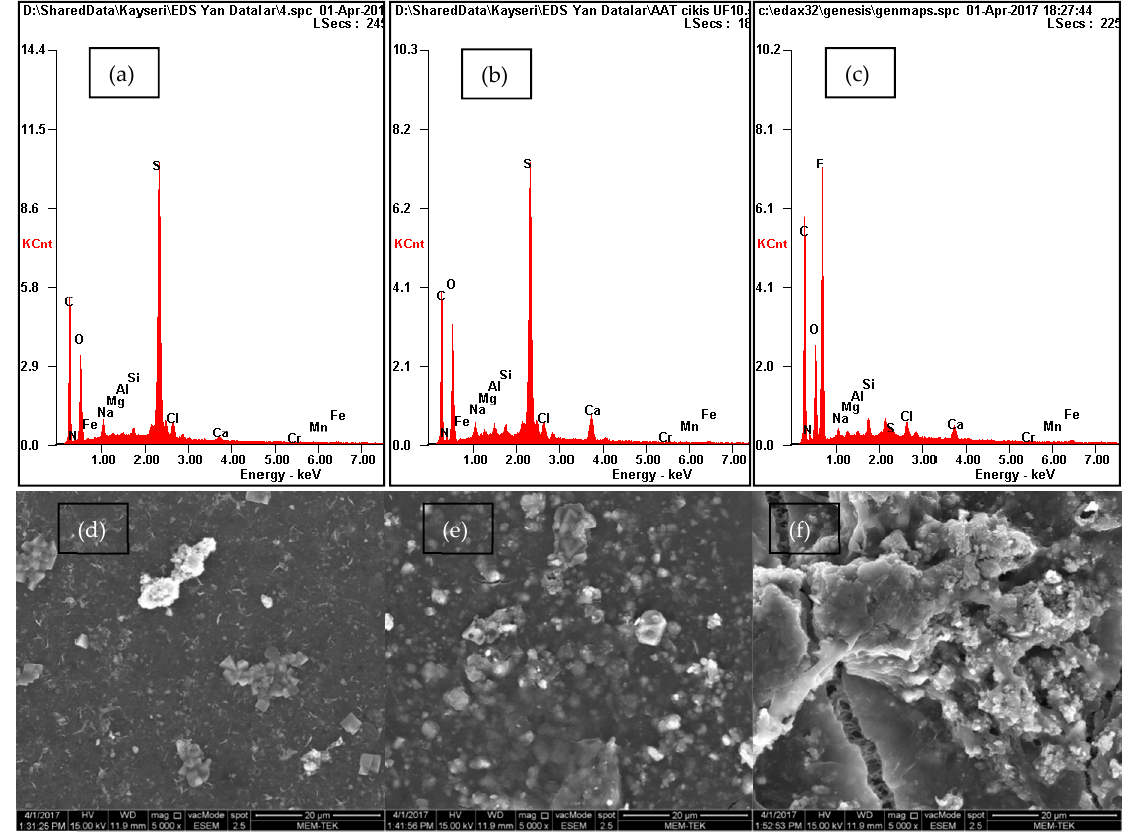
Figure 3. SEM-EDS analysis and SEM photographs of UF membranes; ( a , d ) UF 4 kDa membrane; ( b , e ) UF 10 kDa membrane; ( c , f ) UF 250 kDa membrane